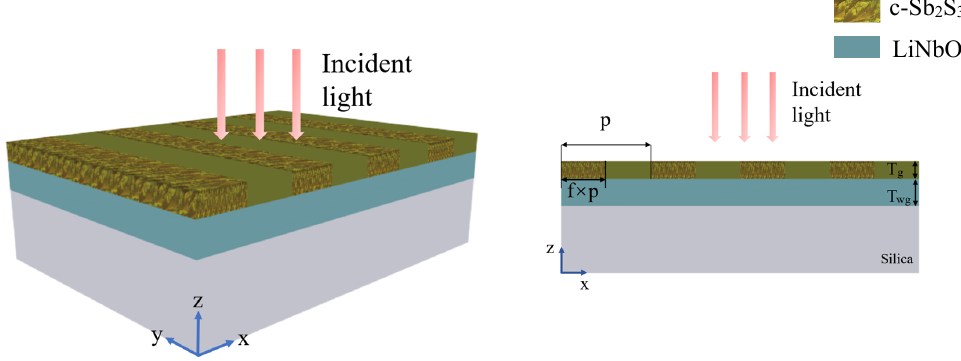
Figure 1. Schematic of a guided mode resonant grating, which consists of a grating layer composed of c_Sb 2 S 3 and a_Sb 2 S 3 , a LN waveguide layer and a SiO 2 substrate of semi-infinite